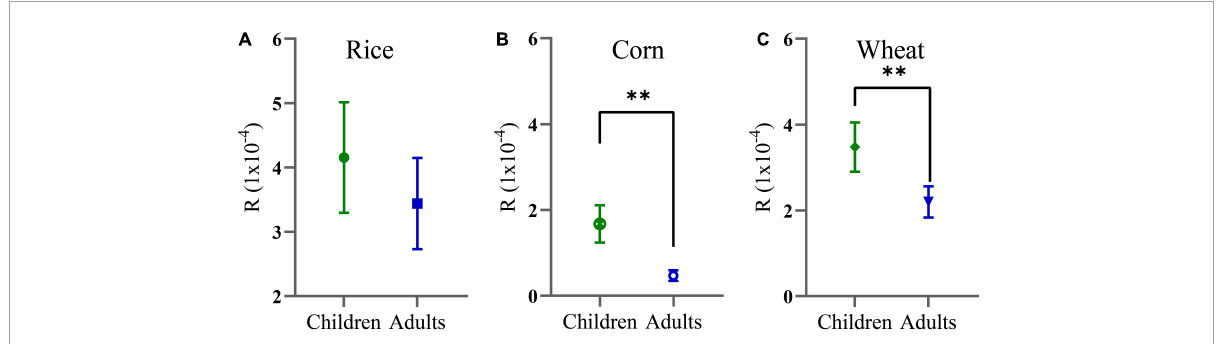
FIGURE4 Carcinogenic risks (R) of Cd in rice (A) , corn (B) , and wheat (C) grains. ∗∗ p < 0.01.